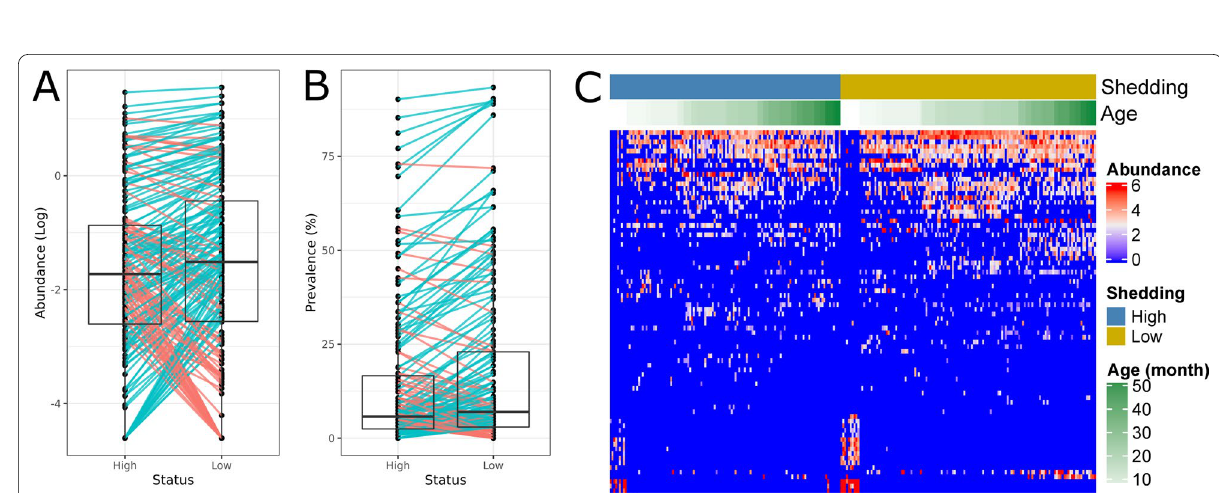
Fig. 5 ASVs significantly contributed to Random Forest model classification accuracy. The boxplots show differences in log transformed averaged abundance ( A ) and average prevalence ( B ); green (higher in “Low” group) and red (higher in “High” group) lines represent differences in abundance or prevalence of individual ASVs. C Heatmap shows CSS normalized abundance of the ASVs, with samples arranged in columns and ASVs in